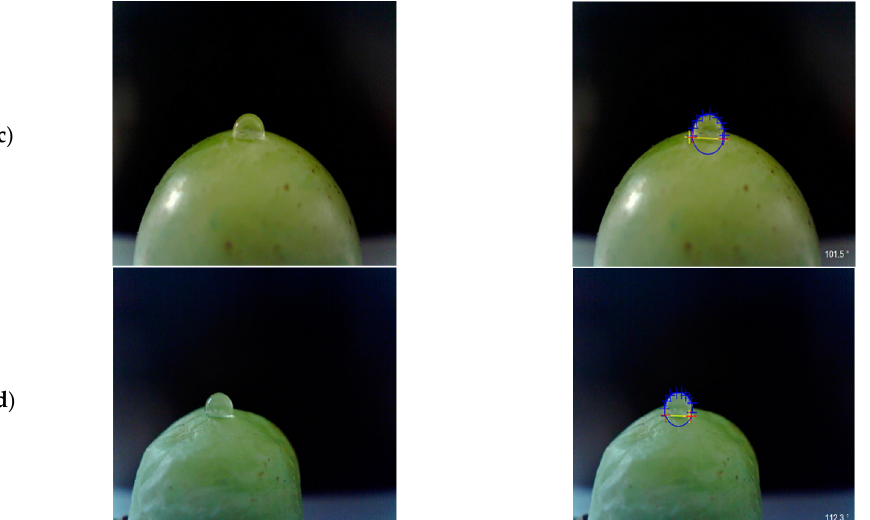
Figure 7. Images of grapes selected to measure the contact angle ( θ ): ( a ) non-coated grapes after 1 day of storage; ( b ) coated grapes after 1 day of storage; ( c ) coated grapes after 5 days of storage; and ( d ) coated grapes after 11 days of storage.